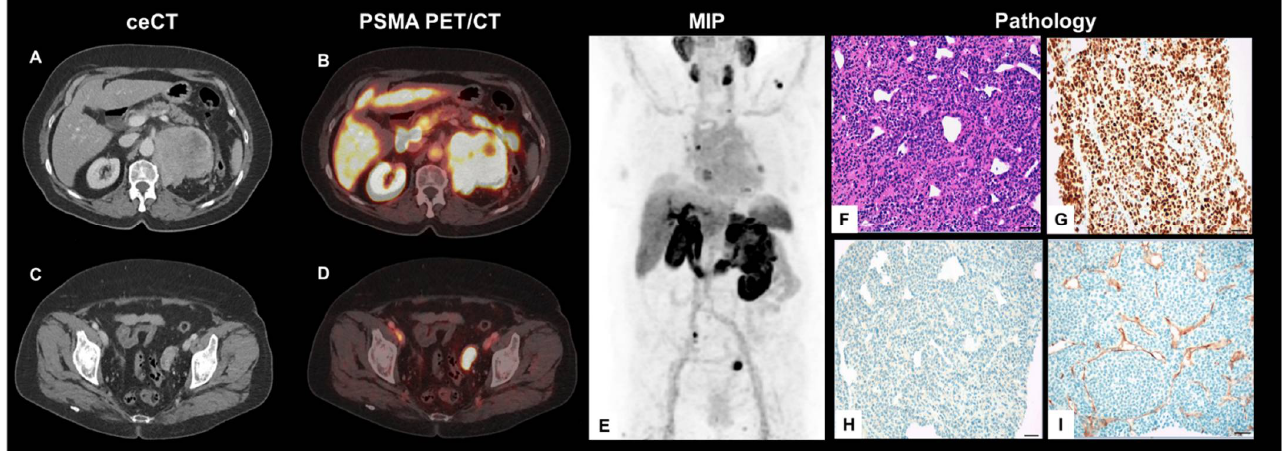
Figure 1. Axial, contrast-enhanced CT (ceCT) ( A , C ) and fused PET/CT planes ( B , D ), MIP ( E ) as well as histology findings from ultrasound-guided biopsy ( F – I ) (Scale bar = 50 µm).